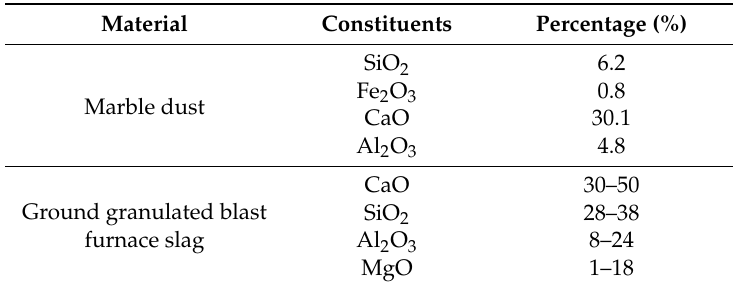
Table 3. Properties of industrial by-products.